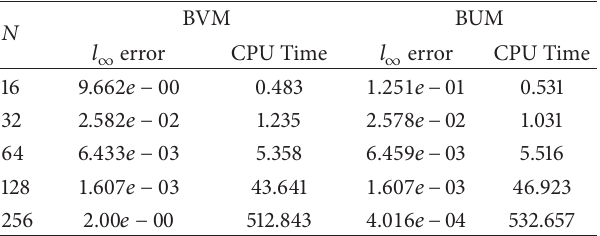
Table 9: Computational results for V = 2 for Example 5.5. 𝑁